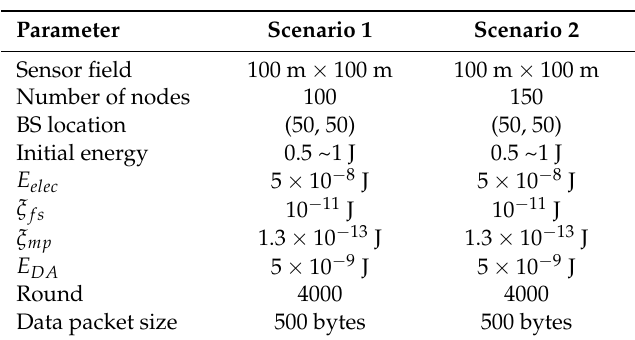
Table 3. Simulation